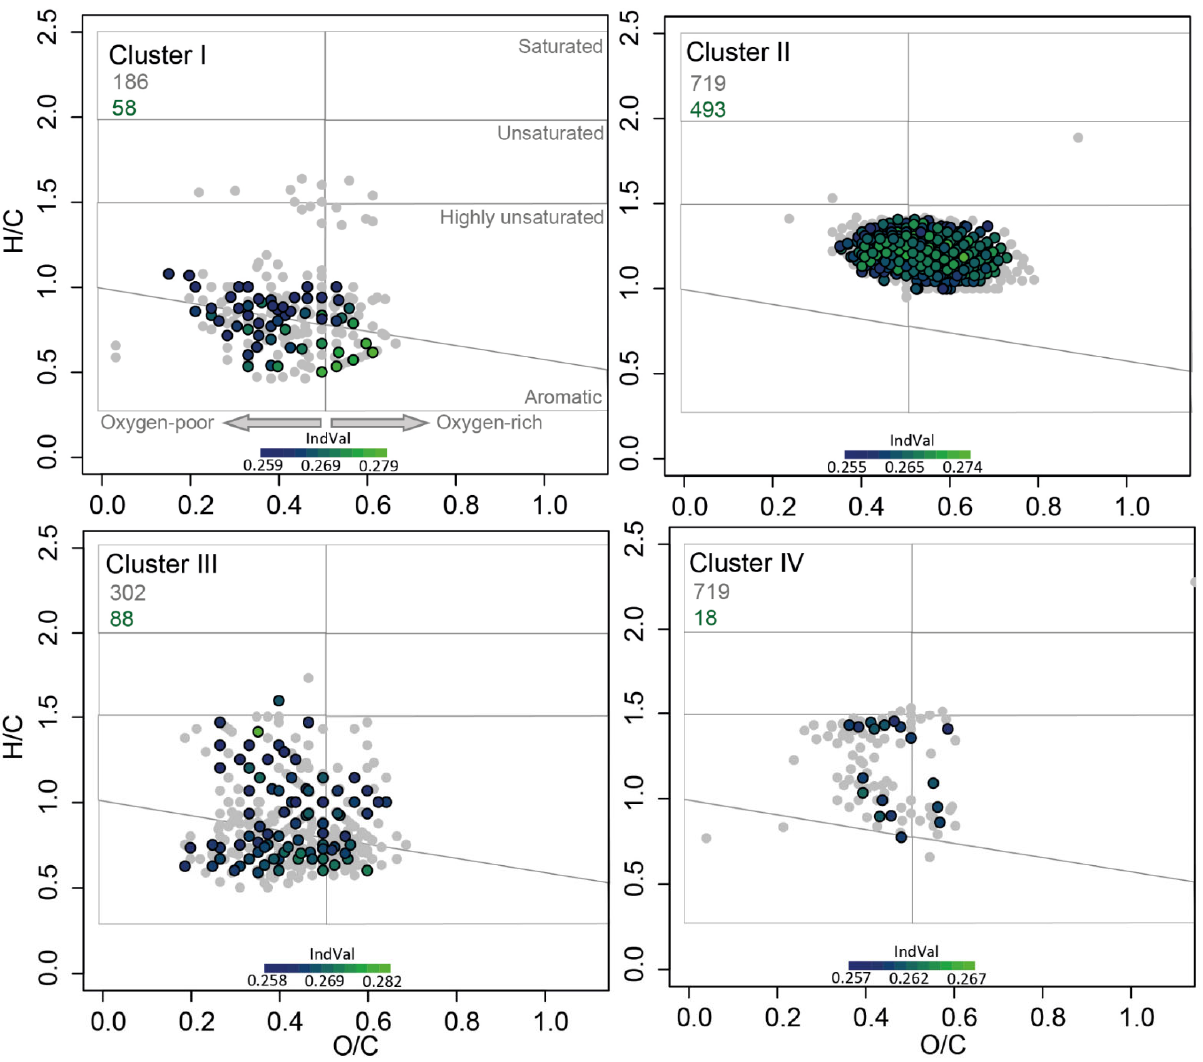
Figure 2. Van Krevelen plots of all DOM compounds linked to one of the four bacterial clusters. Grey dots indicate masses correlated, but not significant after p ‐ adjustment . Colored dots are also correlated significantly after p ‐ adjustment. Grey numbers give the amount of related masses, colored numbers the proportion that is significant after p ‐ adjustment. The color scale represents IndVal, with higher IndVals indicating stronger correlations.